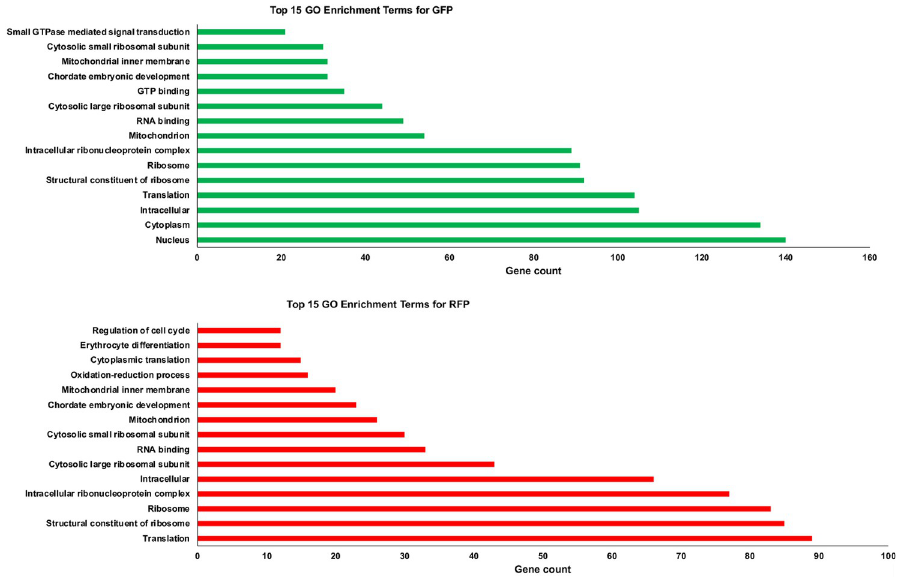
Fig 5. Gene ontology analysis of GFP+ and RFP+ thrombocyte transcripts. The highly expressed gene lists for GFP + and RFP+ thrombocytes were analyzed separately using DAVID to identify gene ontology (GO) categories. The top 15 GO enrichment analysis of A. GFP+ thrombocytes and B. RFP+ thrombocytes by DAVID functional analysis. Bars represent the number (x-axis) of highly expressed genes in pathways (y-axis) for each dataset.